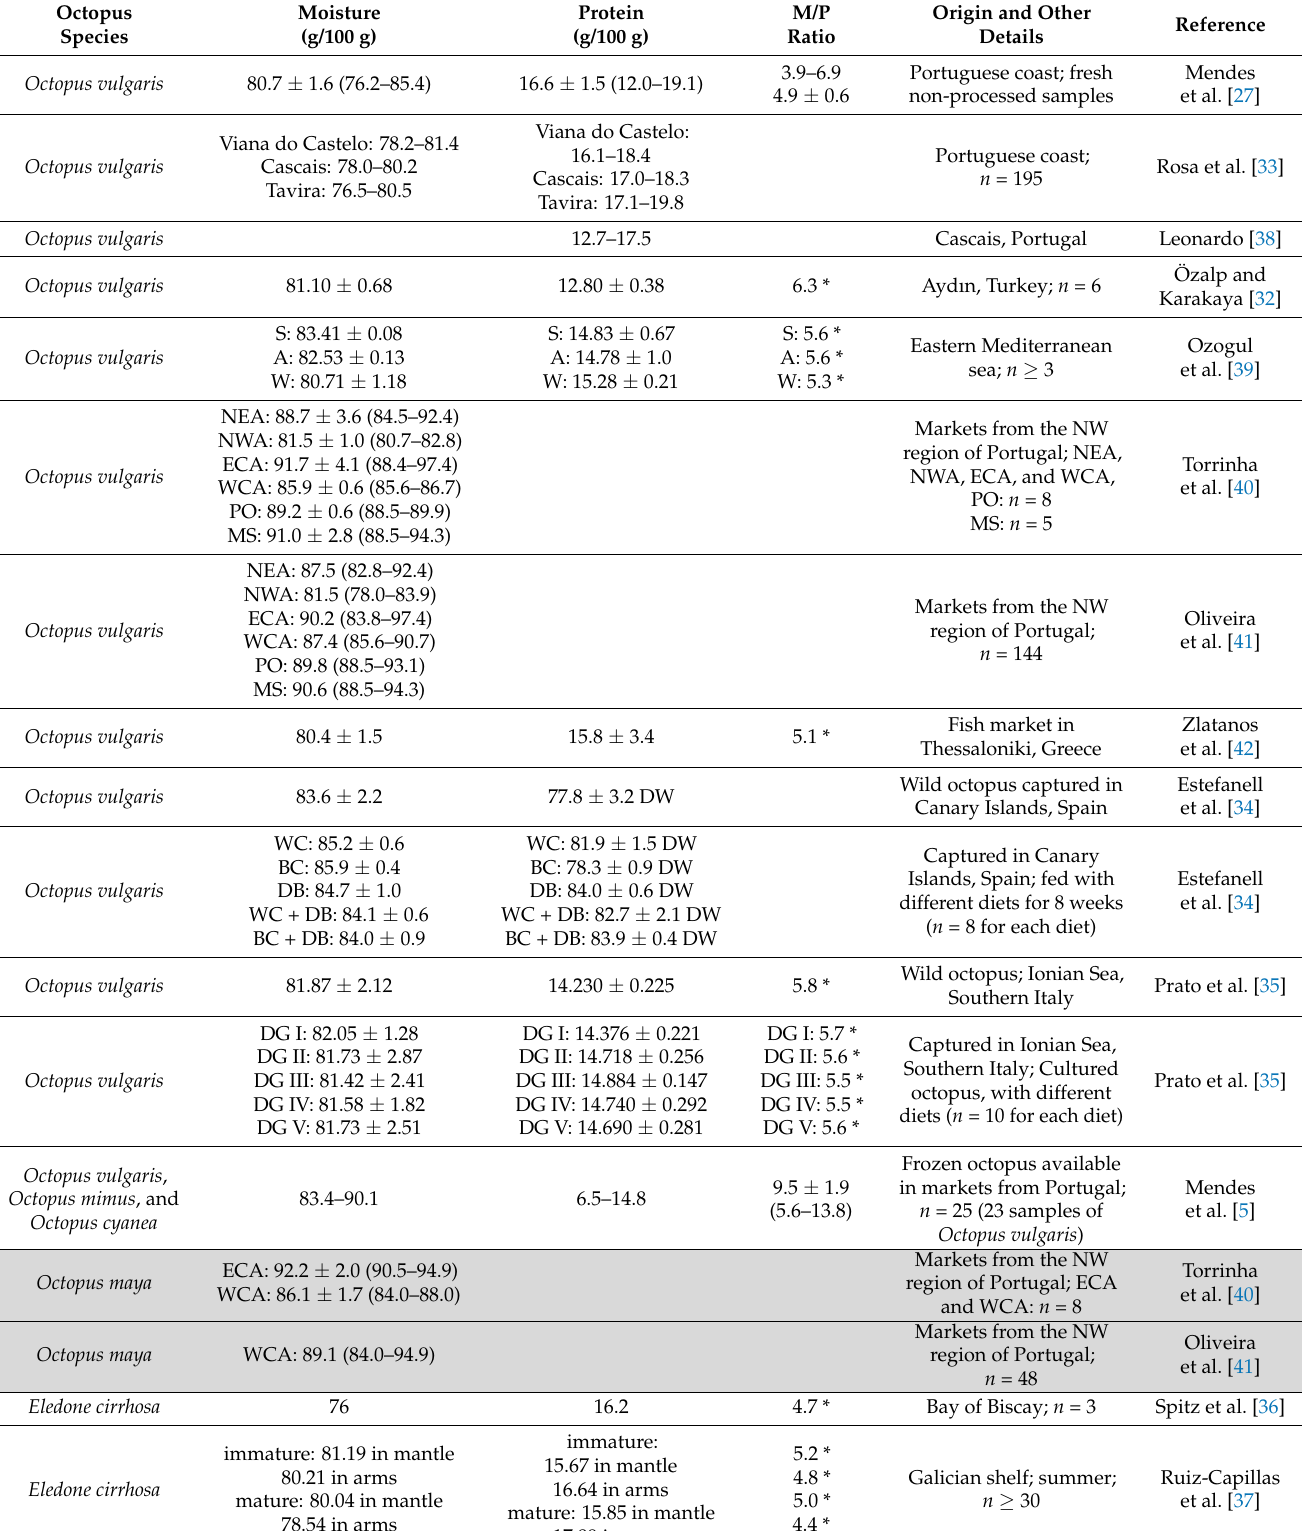
Table 1. Moisture and protein contents in several octopus species from different locations (data from the